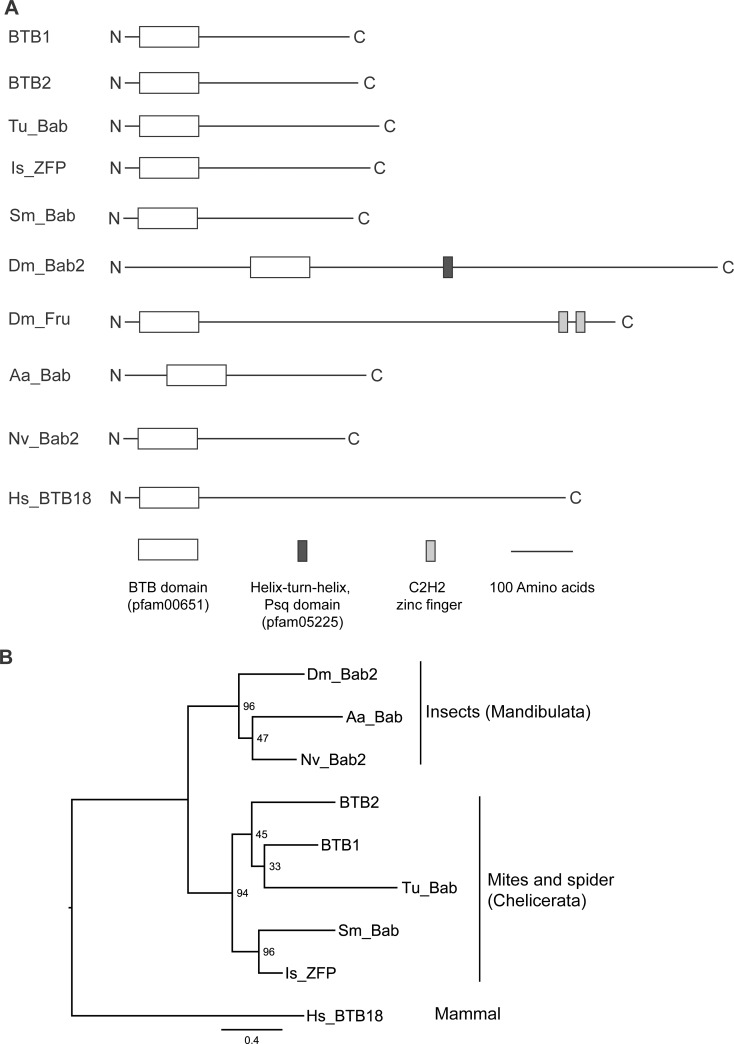
Domain structure and phylogenetic tree of BTB1 and BTB2 proteins of M. occidentalis and their closest homologs from selected species.
(A) Schematic structures of BTB proteins from the chelicerates M. occidentalis, T. urticae (Tu), I. scapularis (Is) and S. mimosarum (Sm), the insects D. melanogaster (Dm), Nasonia vitripennis (Nv) and A. aegypti (Aa), and the mammal H. sapiens (Hs). Names and pfam IDs of conserved domains are shown in brackets. (B) A phylogenetic analysis of BTB proteins from selected species. The tree was generated using a maximum likelihood approach [49] with bootstrap support values shown at the nodes. The tree was rooted using BTB18 of the mammal H. sapiens (Hs_BTB18). The scale bar represents the numbers of substitutions per site.